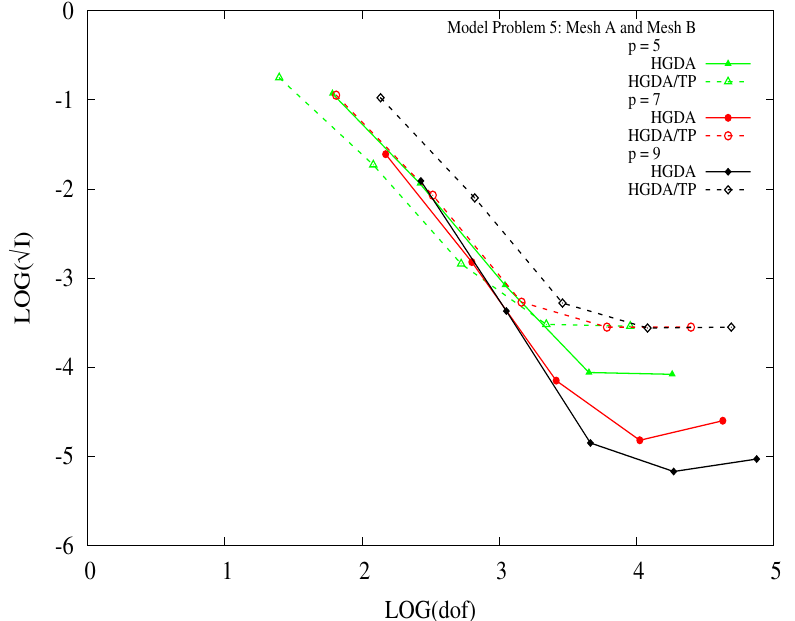
Figure 26. Residual function I versus dof, C 22 solutions: Model Problem 5 (Convection Diffusion Equation; Mesh B, HGDA/DG; Mesh A, HGDA/TP).